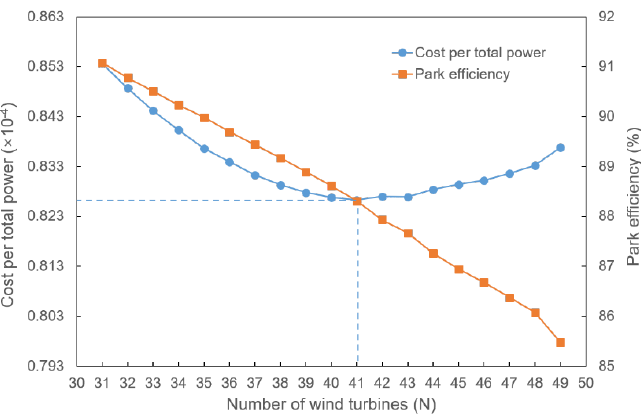
Figure 11. Cost per total power and park e ffi ciency according to the number of wind turbines in case study